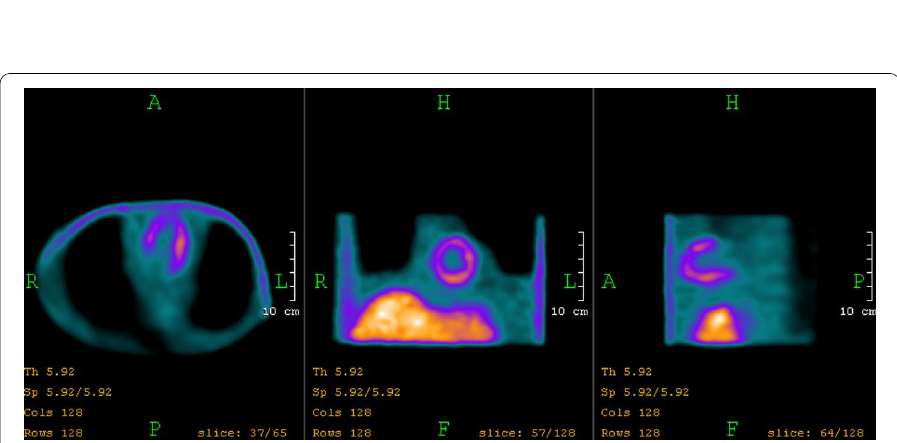
Fig. 8 Reconstructed SPECT image of the LVm healthy phantom inserted in the Anthropomorphic Torso